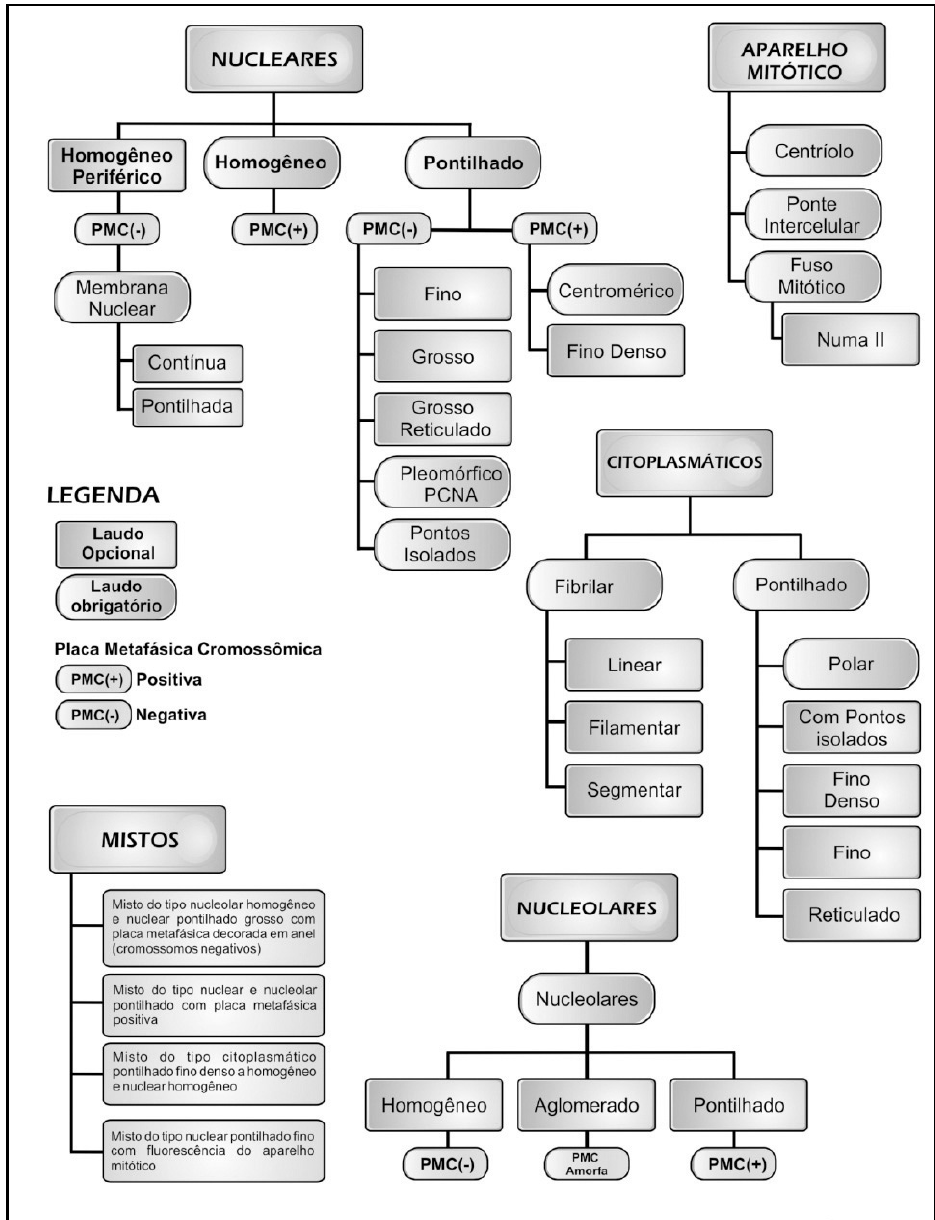
Figura 2 – Árvores de classificação dos padrões nucleares, nucleolares, citoplasmáticos, do aparelho mitótico e